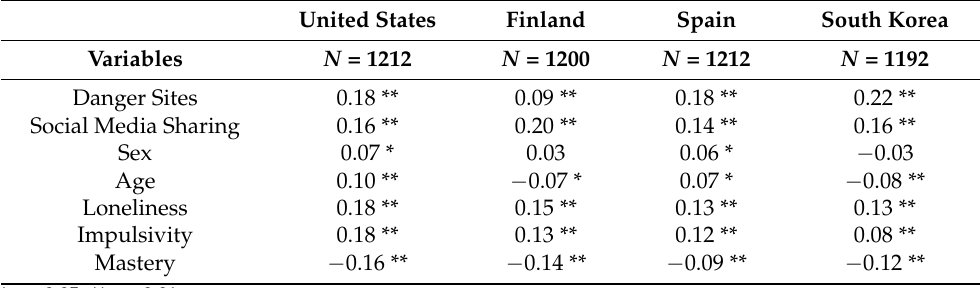
Table 2. Zero-order correlation matrix. Dependent variable cyberharassment victimization.